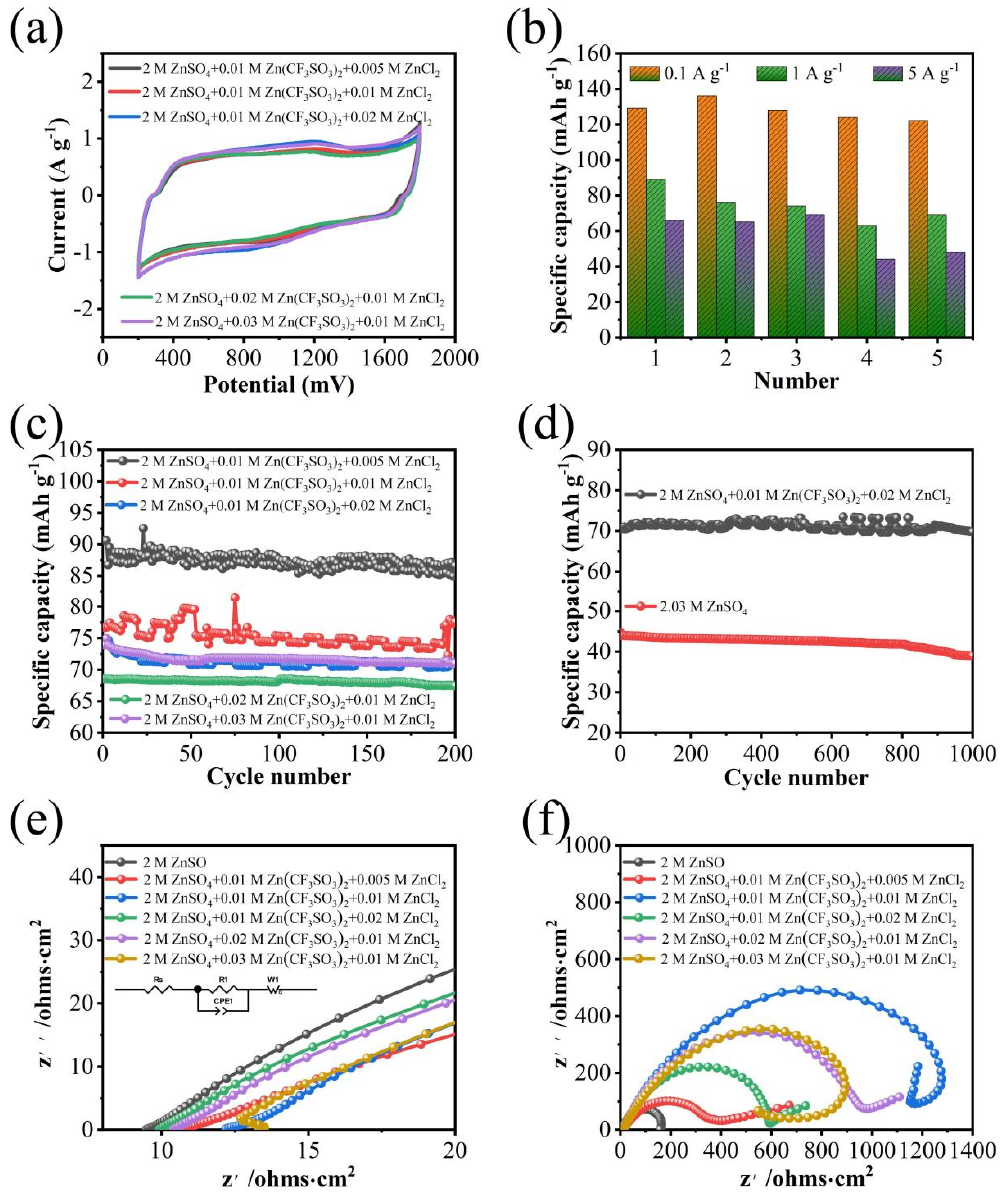
Figure 6. ( a ) Comparison of five CV curves (5 mV s − 1 ); ( b ) Numbers 1, 2, 3, 4, and 5 are 2 M ZnSO 4 + 0.01 M Zn(CF 3 SO 3 ) 2 + 0.005 M ZnCl 2 , 2 M ZnSO 4 + 0.01 M Zn(CF 3 SO 3 ) 2 + 0.01 M ZnCl 2 , 2 M ZnSO 4 + 0.01 M Zn(CF 3 SO 3 ) 2 + 0.02 M ZnCl 2 , 2 M ZnSO 4 + 0.02 M Zn(CF 3 SO 3 ) 2 + 0.01 M ZnCl 2 , and 2 M ZnSO 4 + 0.03 M Zn(CF 3 SO 3 ) 2 + 0.01 M ZnCl 2 electrolytes; ( c ) Cycling performance (1 A g − 1 ) of hybrid anionic electrolyte; ( d ) Cycling performance (5 A g − 1 ) of electrolyte with the same Zn 2+ concentration; ( e ) Nyquist plot of hybrid anionic electrolyte in high-frequency region; ( f ) Nyquist plot of hybrid anionic electrolyte.